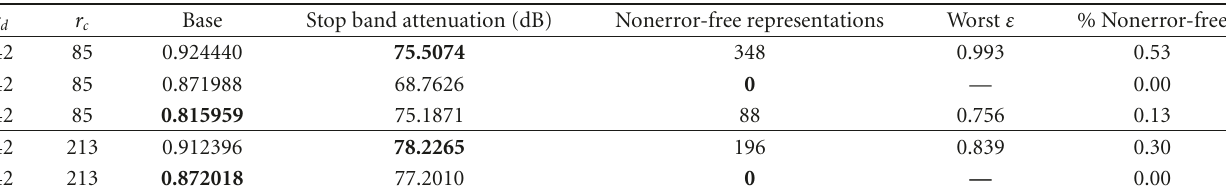
Table 5: Combined optimal base (single-digit coe ffi cient, two-digit